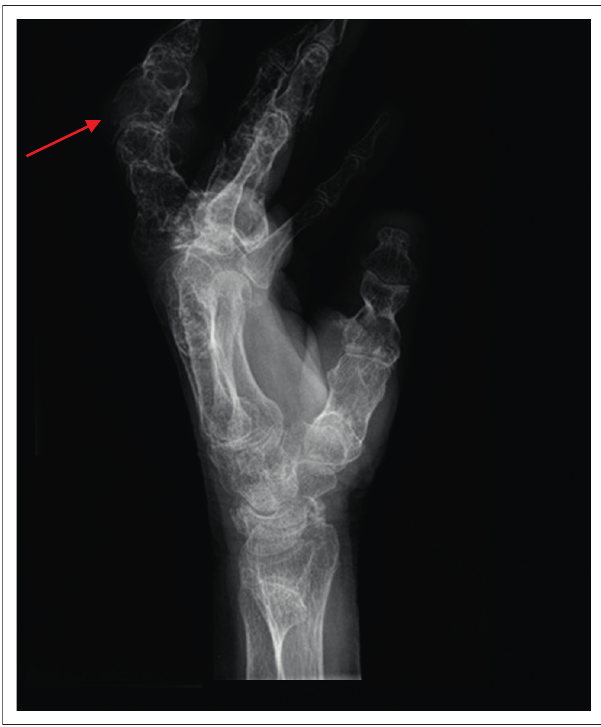
FIGURE 6: Lateral radiography displays soft-tissue extension and dorsal cortical destruction of the right intermediate phalynx of the right middle finger (red arrow).